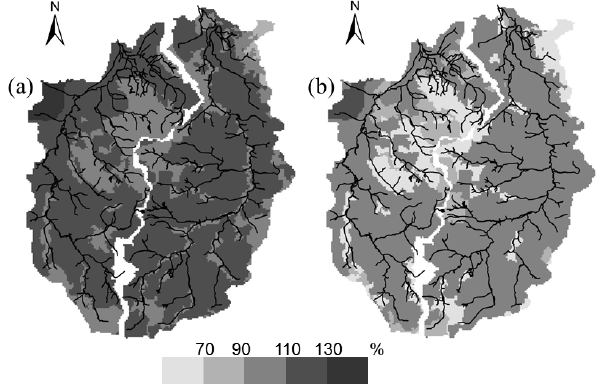
Fig. 5. Ratio between annual runoff generation for the scenarios and the reference period (a) scenario A, (b) scenario